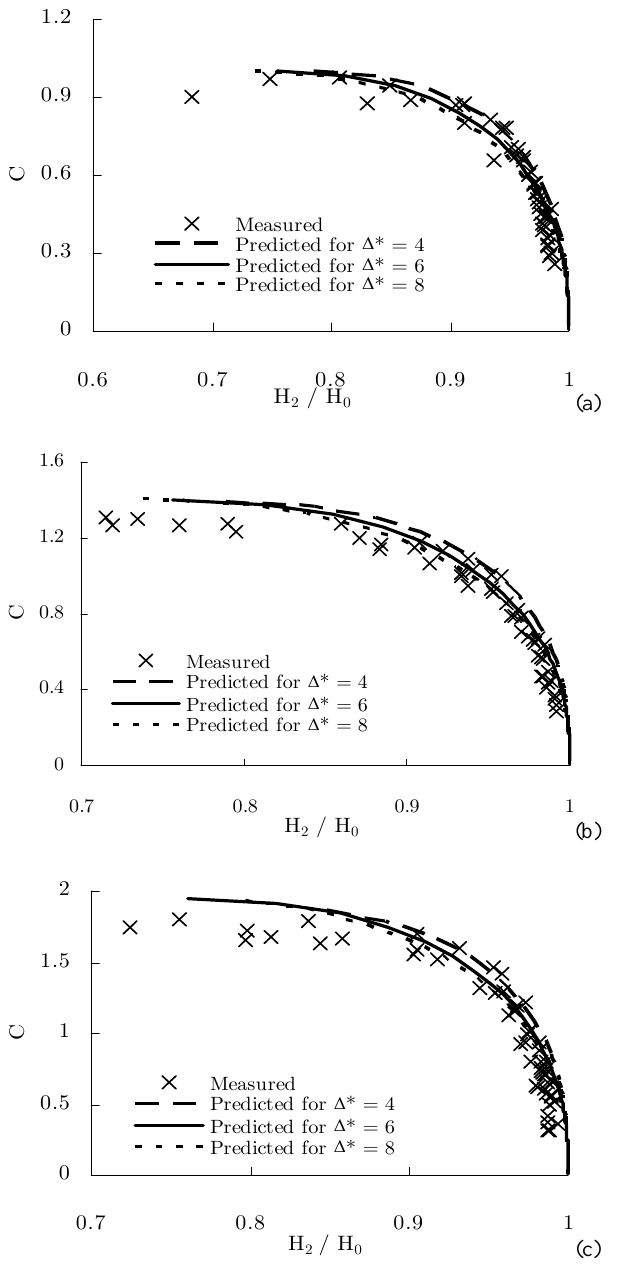
Fig. 13. Discharge coefficients (based on channel width ( B = L · cos ϕ )) for different angles of obliqueness, measured (De Vries, 1959; Tuyen, 2006) and predicted data is compared for different downstream water levels; inclination angle 0 ◦ (a) , 45 ◦ (b) , 60 ◦ (c) .